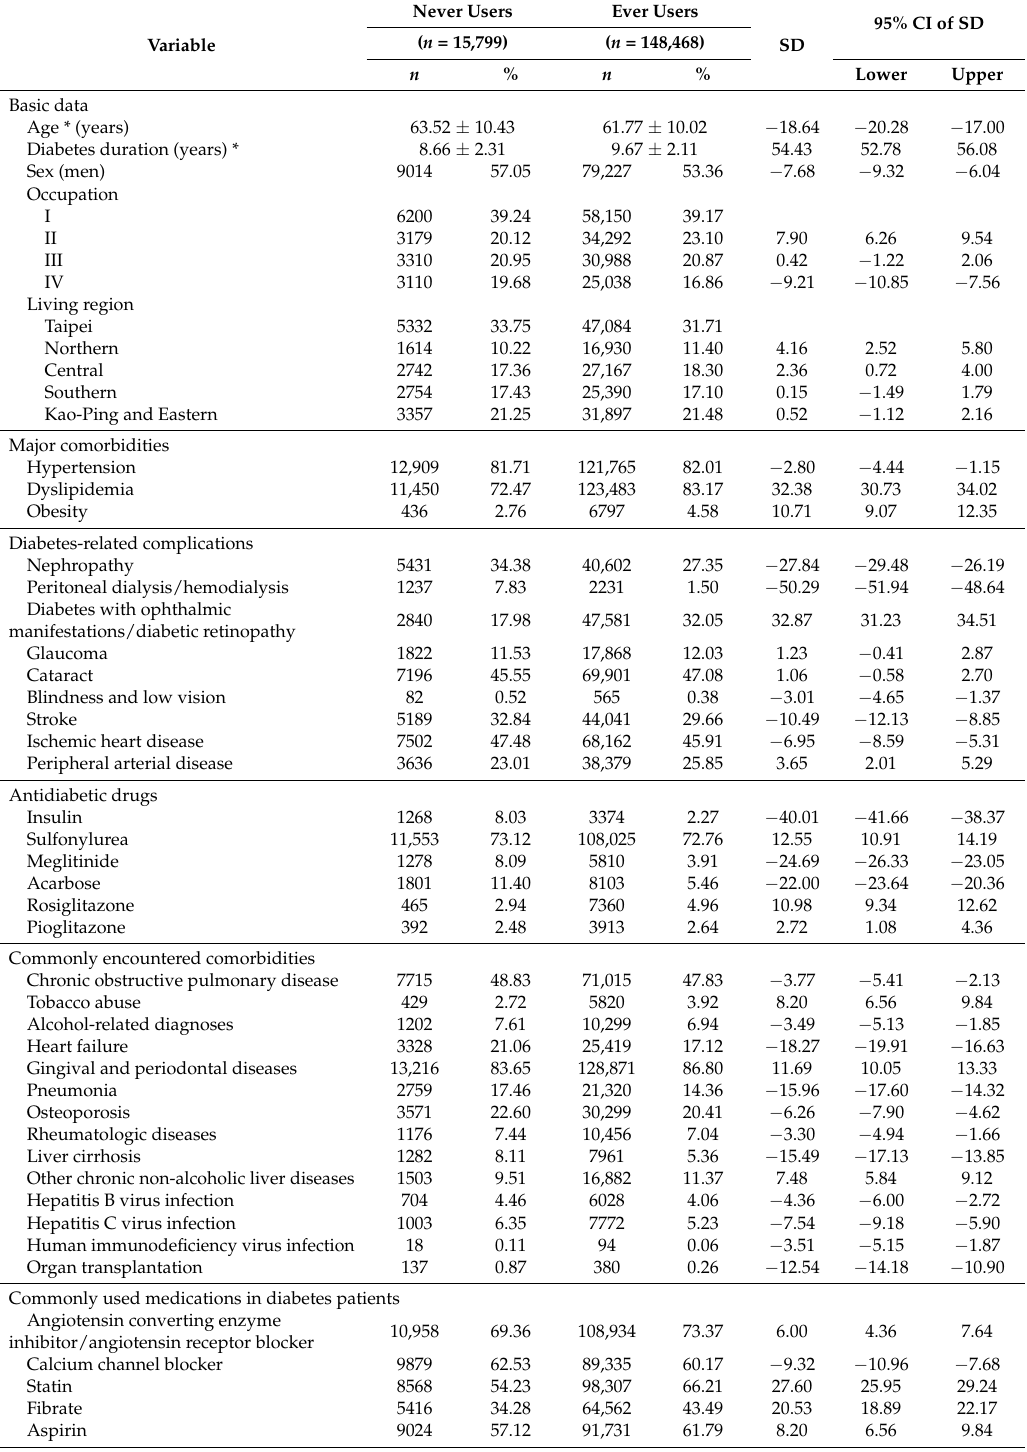
Table 1. Characteristics of metformin never users and ever